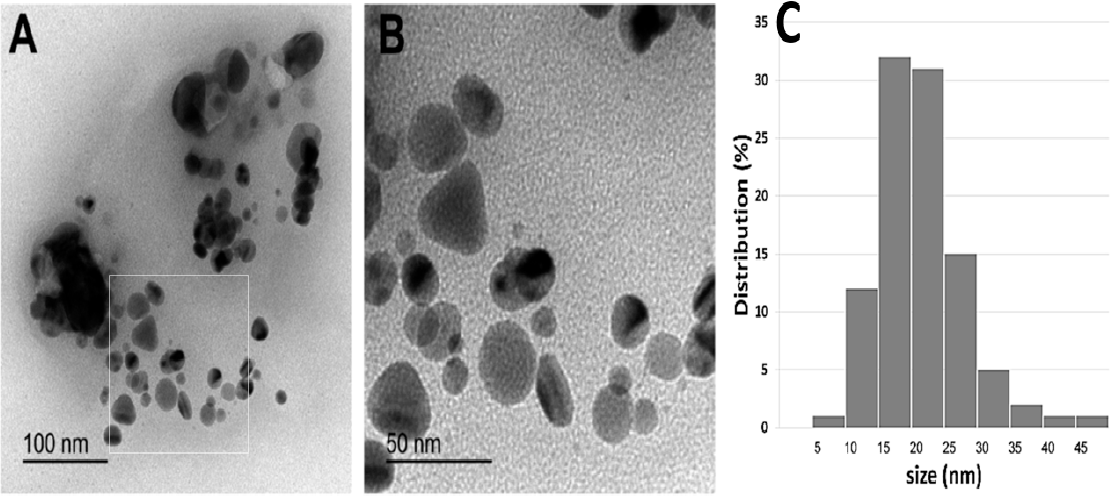
Figure 2. ( A , B ), different shapes and sizes of silver nanoparticles as detected by TEM; ( C ) particle size distributions.